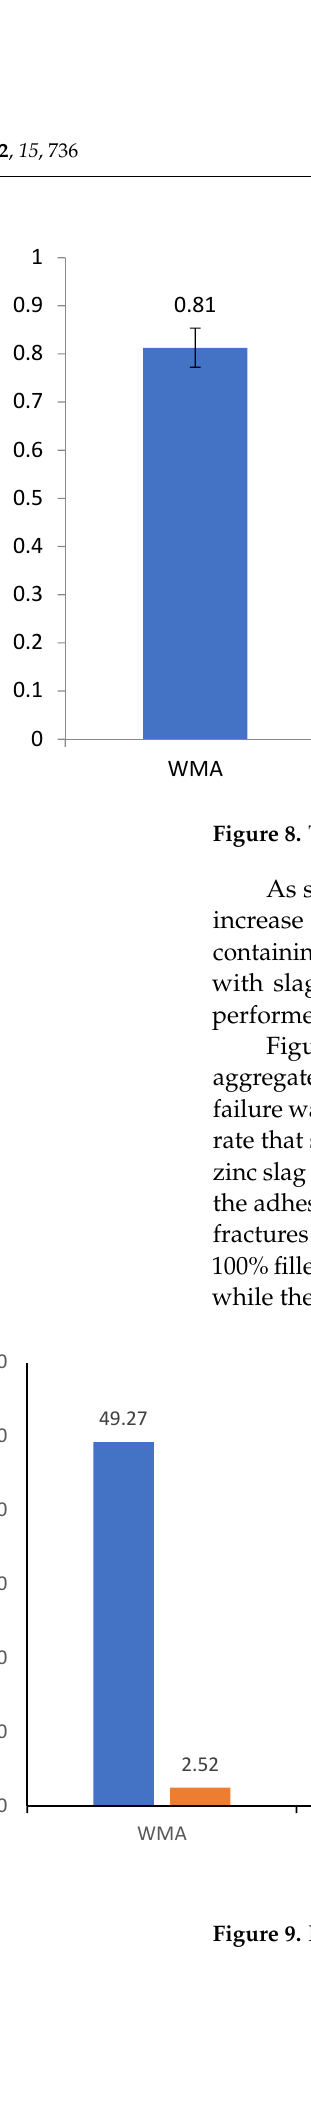
13 of 22 Figure 7. ITS diagram of the asphalt samples in dry and saturated states.